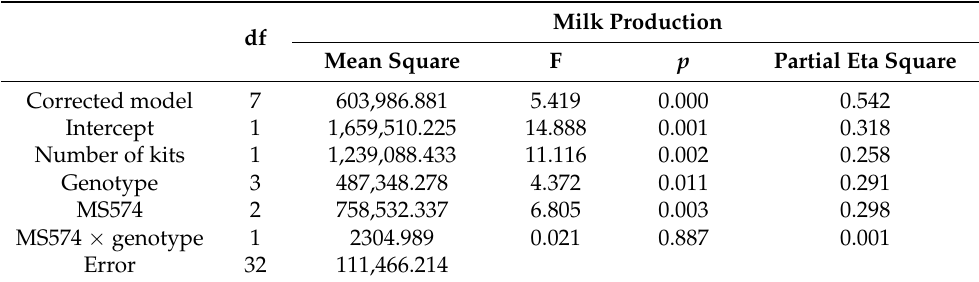
Table 3. Association of milk production (21 ‐ day total milk volume) with polymorphisms of PRLR (Generalized Linear Model (GLM), the number of kits were covariant.